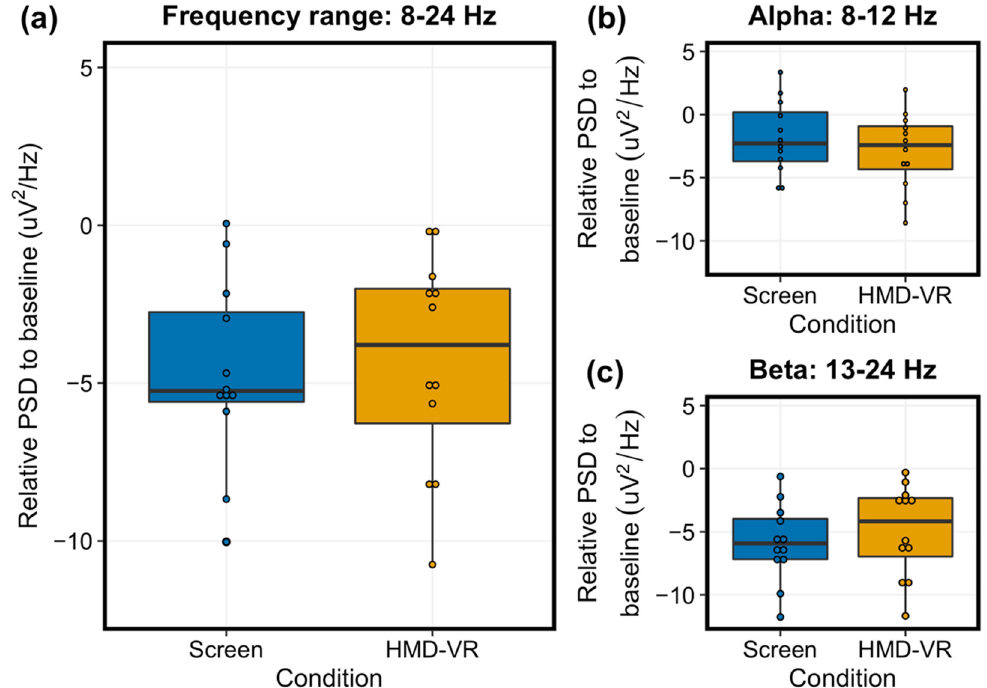
Figure 5. Average power spectral density during trials between conditions. ( a ) The relative group-level PSD for the target electrode C3, representing the left motor cortex (8-24 Hz) between the Screen (left, blue) and HMD-VR (right, yellow) conditions was not significantly di ff erent. ( b ) The relative group-level alpha between the Screen (left, blue) and HMD-VR (right, yellow) conditions was also not significantly di ff erent. ( c ) The relative group-level beta between the Screen (left, blue) and HMD-VR (right, yellow) conditions was also not significantly di ff erent.